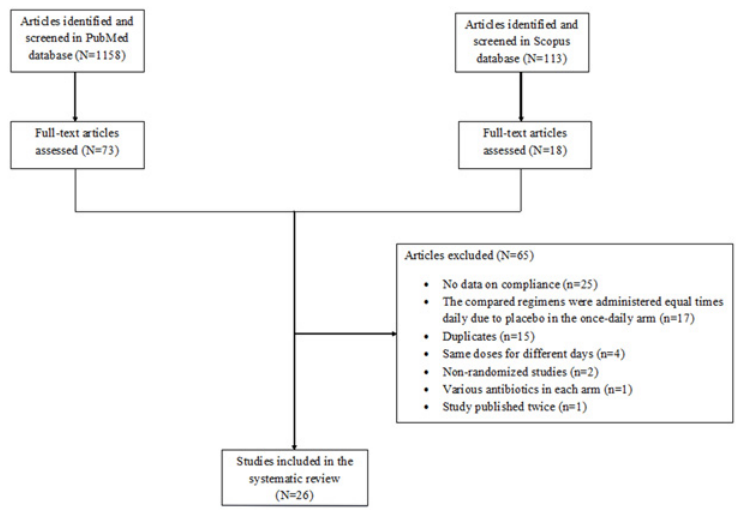
Figure 1. Flow diagram of the systematic search and study selection